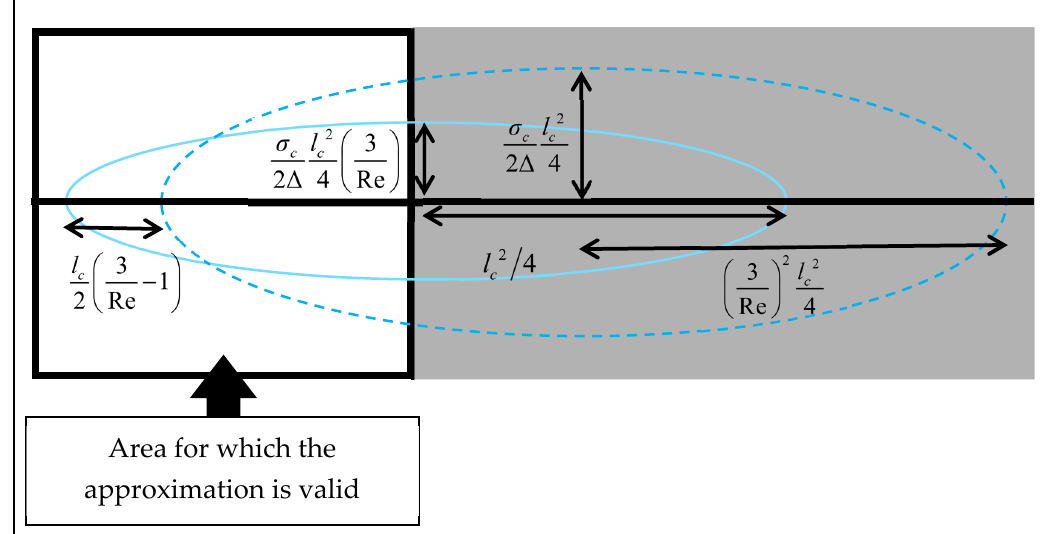
Figure 2. A scheme of the bubble dimensions change.